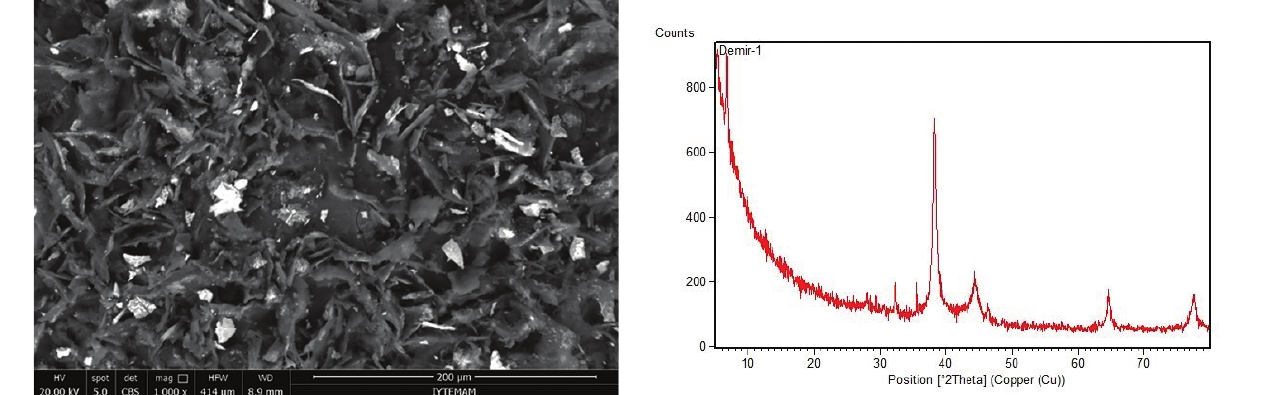
Figure 7: X-ray diffraction (XRD) patterns of the FeNP A by ASP